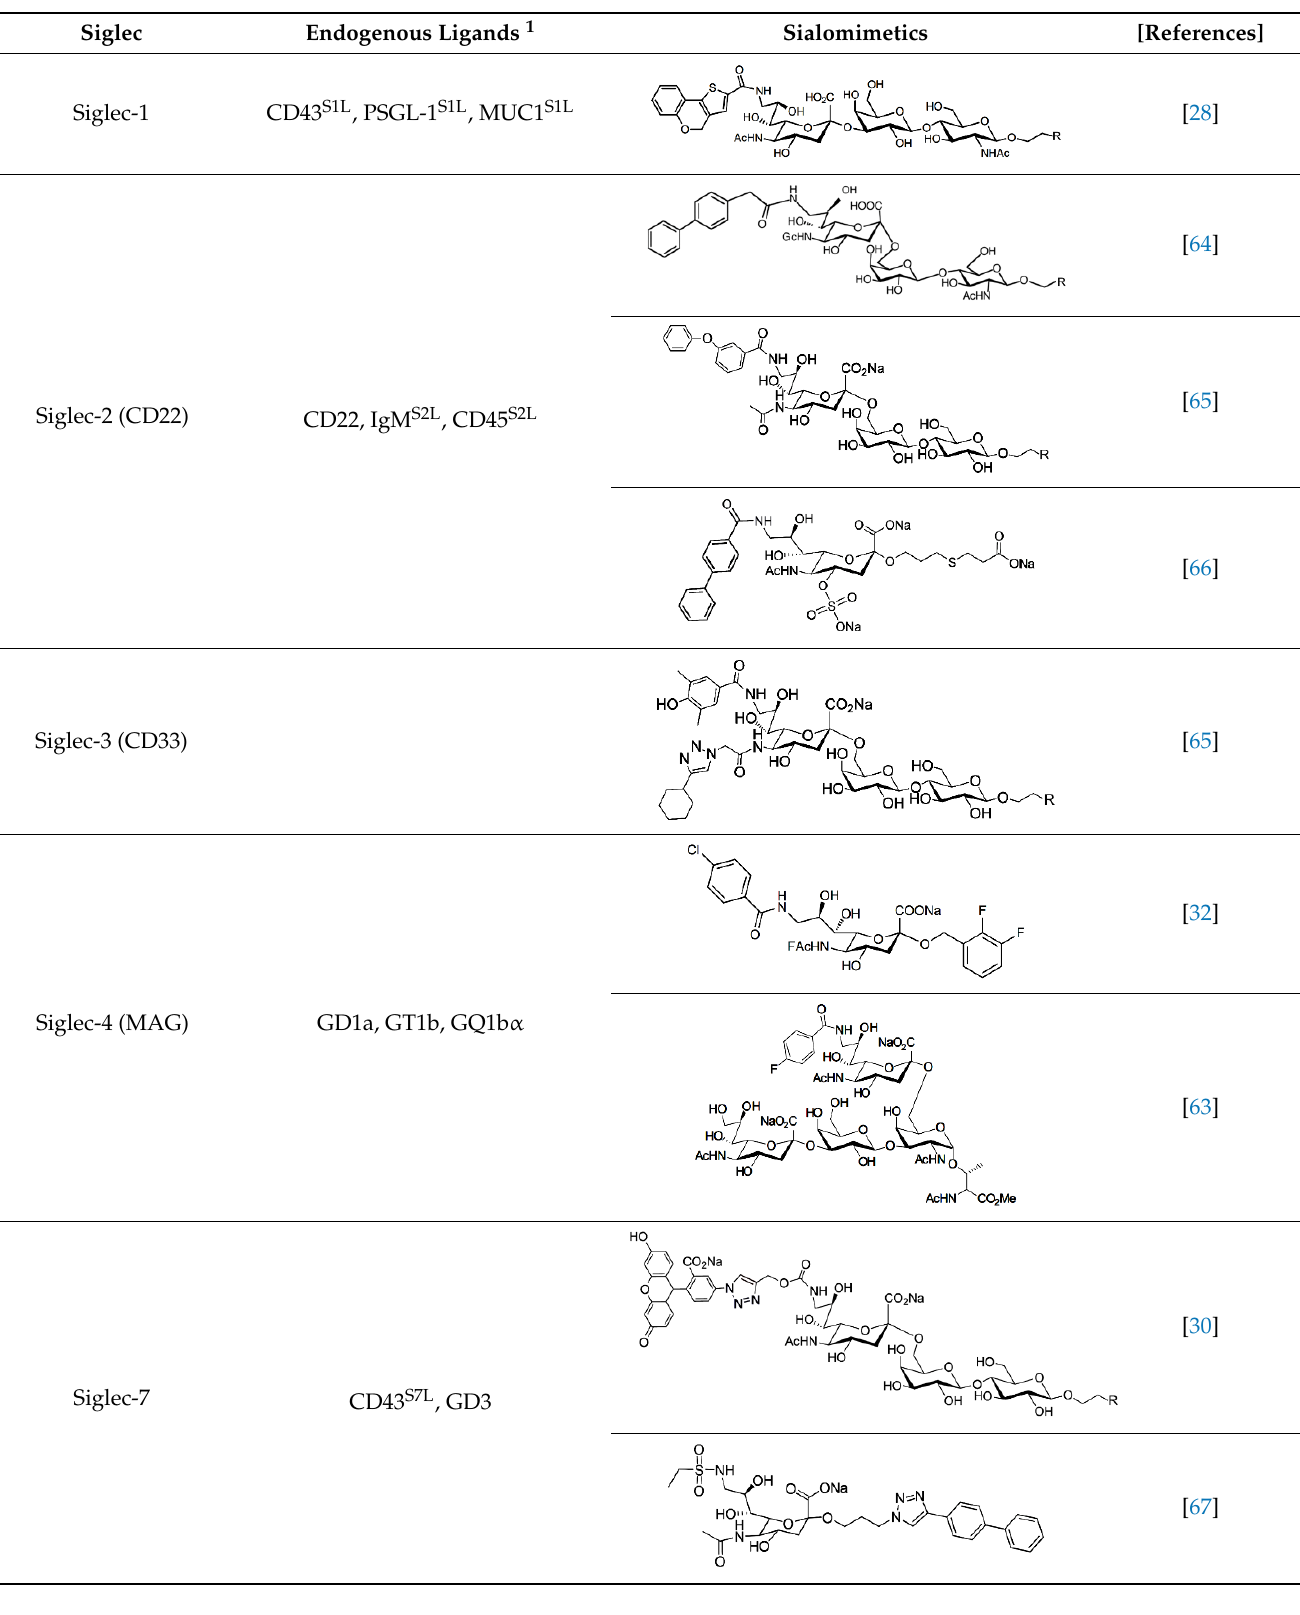
Table 2. Endogenous Siglec ligands and Siglec-targeting sialomimetics.